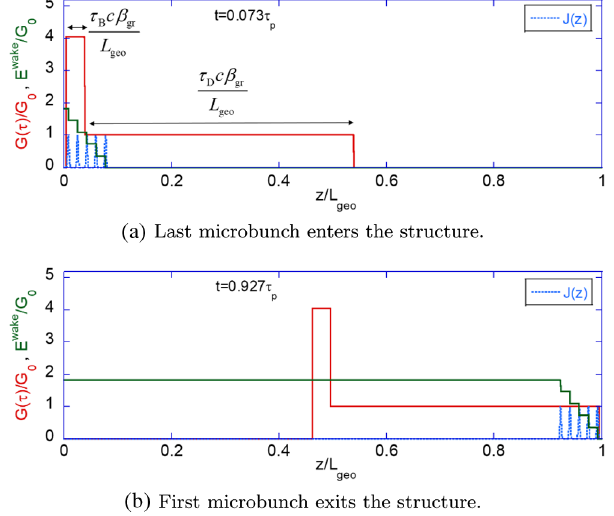
FIG. 2. Laser pulse ’ s envelope (red), normalized to G 0 ¼ 8 GV = m, propagates at β 0 . 5 , while the wake (green), gr ¼ generated by five relativistic microbunches (blue), propagates at their velocity. The above three quantities are presented for two different time frames: (a) last microbunch enters the structure, (b) first microbunch exits it. First, a gradient G 0 is applied for a delay time τ , and then a 3 G 0 amplitude correction is added for D the remainder of the pulse. The time each microbunch spends in such “ correction-zone ” compensates for the wake it experiences while traversing the